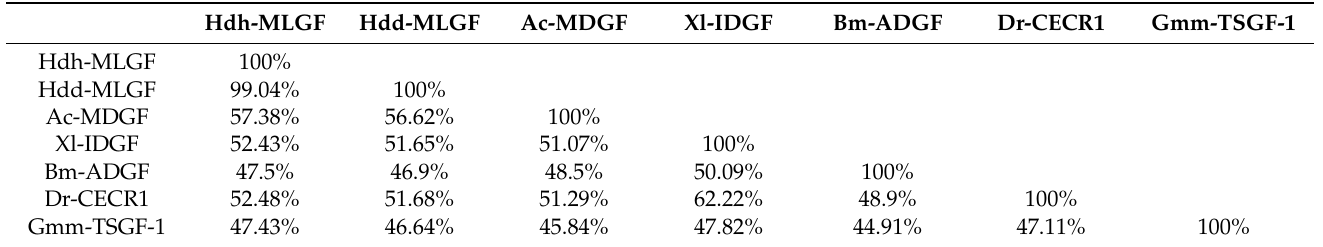
Table 3. Amino acid percent similarity of Hdh-MLGF compared with other members in the ADGF subfamily.